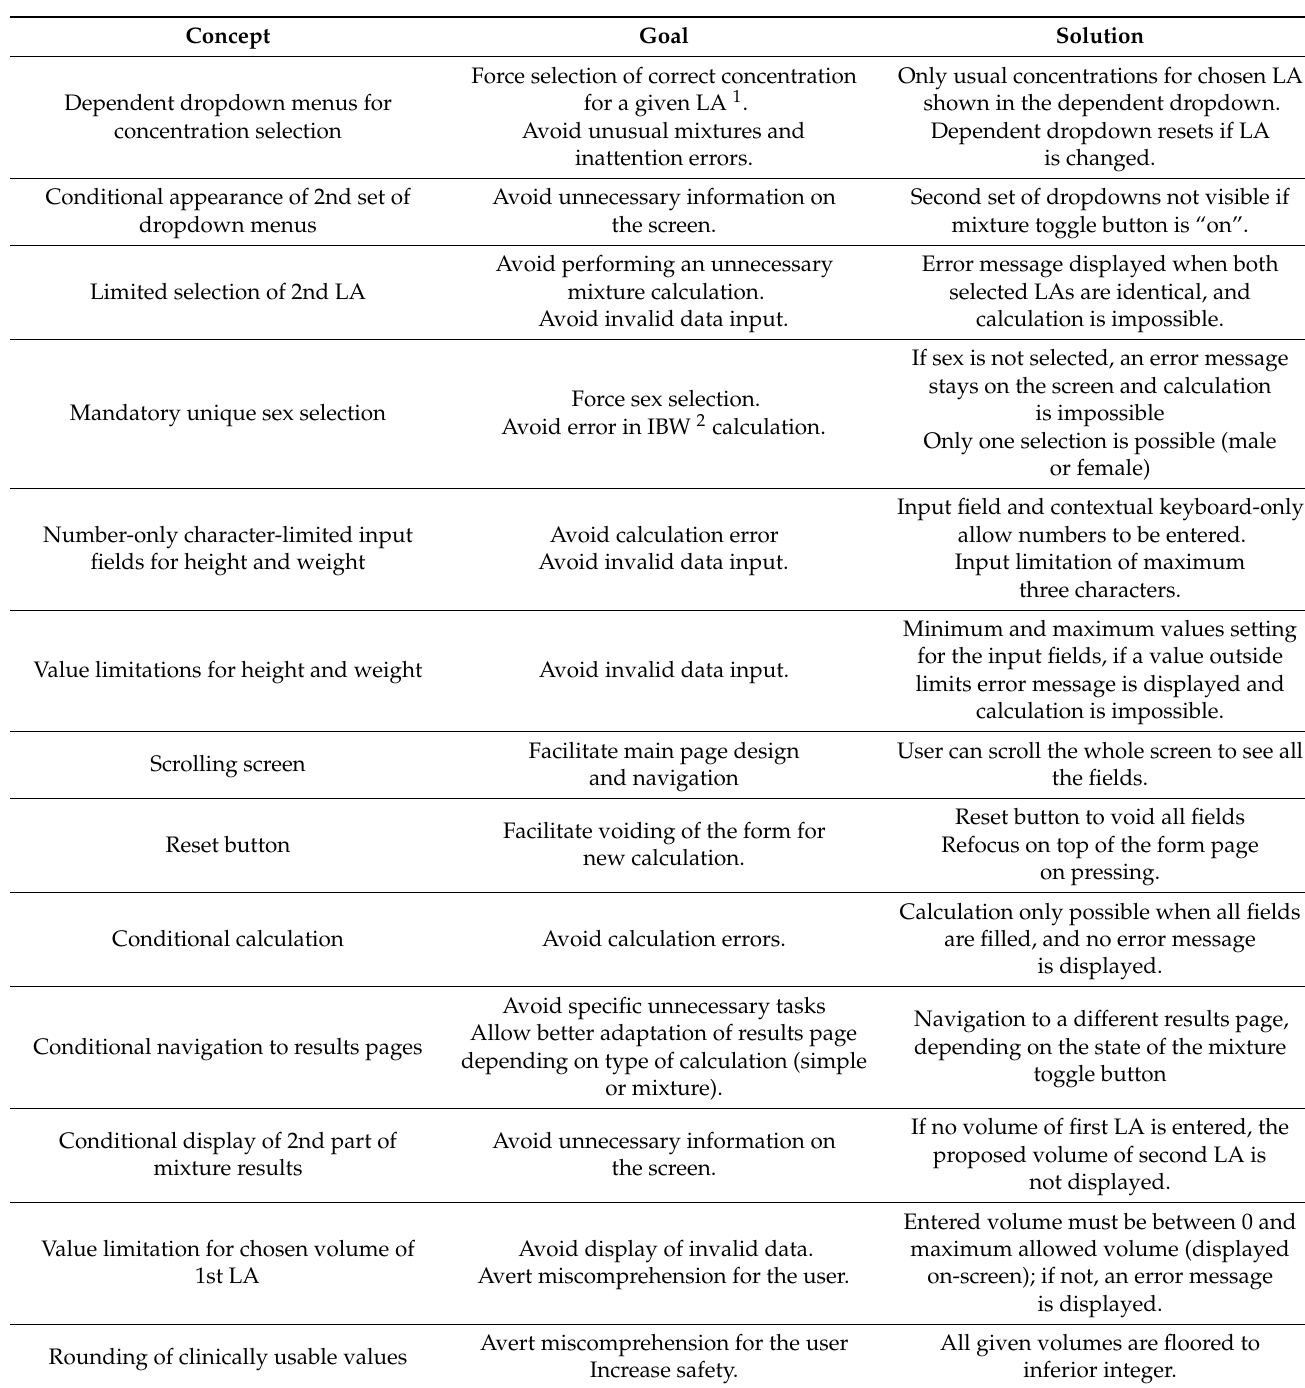
Table 4. Concepts retained for app